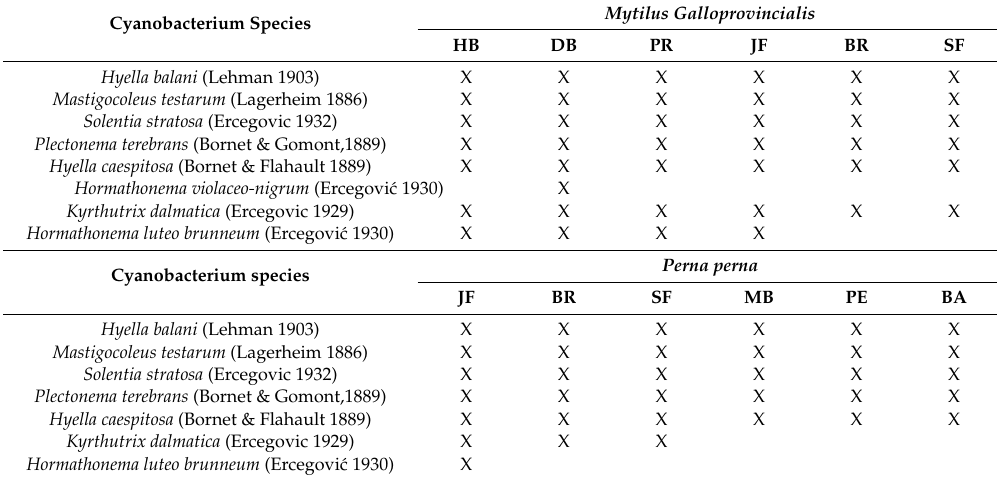
Table 2. List of identified endolithic species in all study sites for each species. Full site names refer to Table